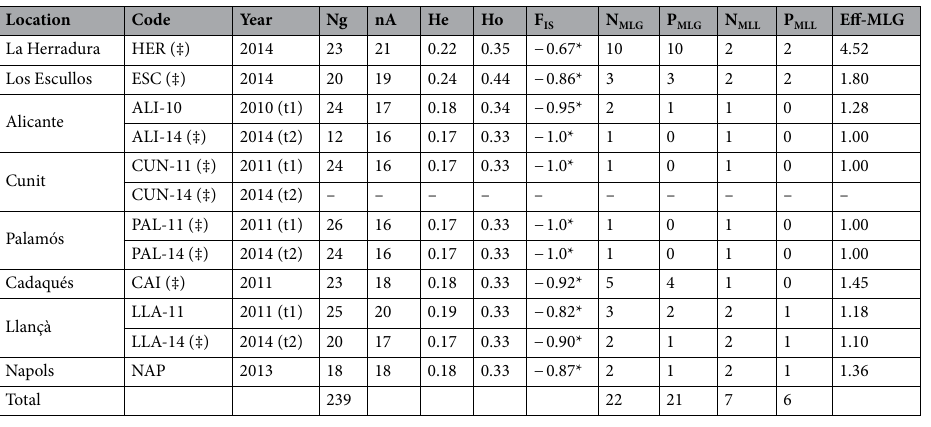
Table 1. Information of W Mediterranean localities of C. tenuispina used for spatial and temporal analyses: location, code, year of collection, number of individuals genotyped (Ng), number of alleles (nA), expected and observed heterozygosity (He and Ho, respectively), F IS considering all individuals (* when p -value < 0.01 for HWE), number of MLGs (N MLG ), number of private MLG (P MLG ), number of MLLs (N MLL ), number of private MLL (P MLL ), and clonal richness (Eff-MLG). For further details see Supplementary material S1 and S2. (‡) New samples collected for this